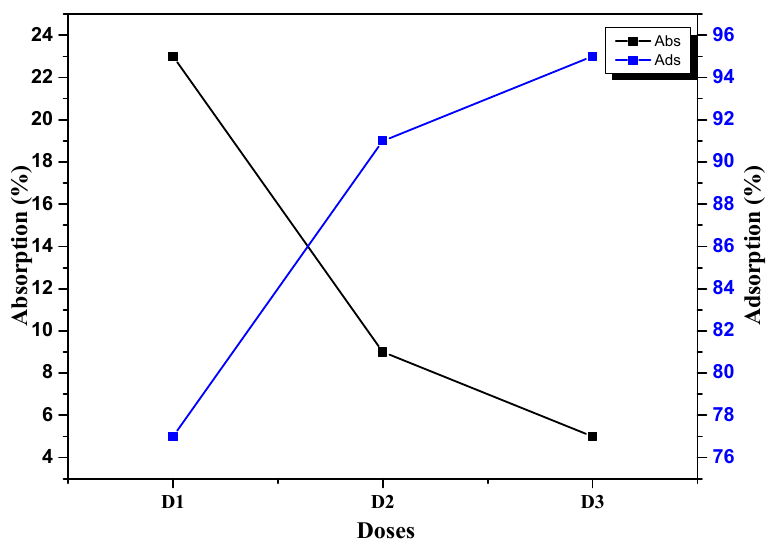
Figure 12. Increasing trend of the adsorption percentages (blue line) and decreasing absorption (black line) of Ni with respect to the doses applied for genotype G1.